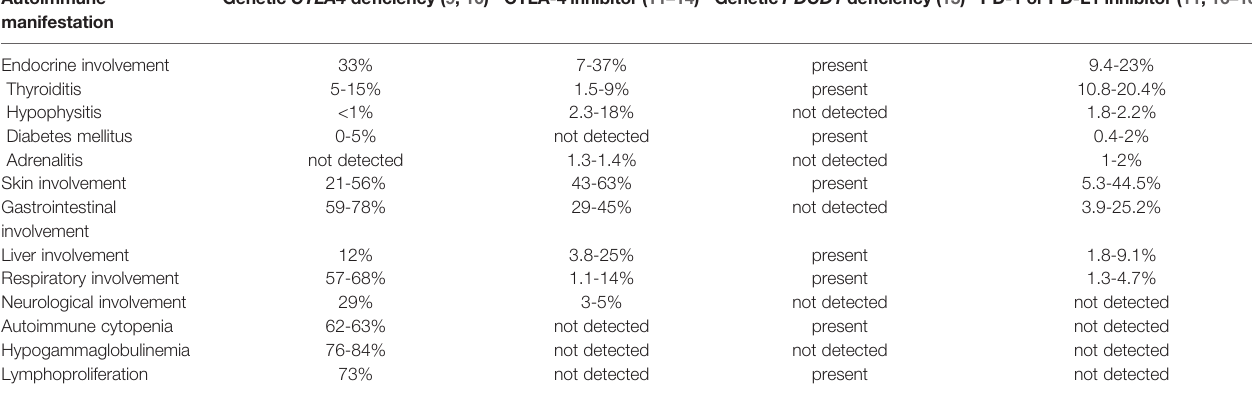
TABLE 1 | Comparison of autoimmune manifestations in genetic de fi ciency versus pharmacological inhibition of CTLA-4 and PD-1/PD-L1. Autoimmune